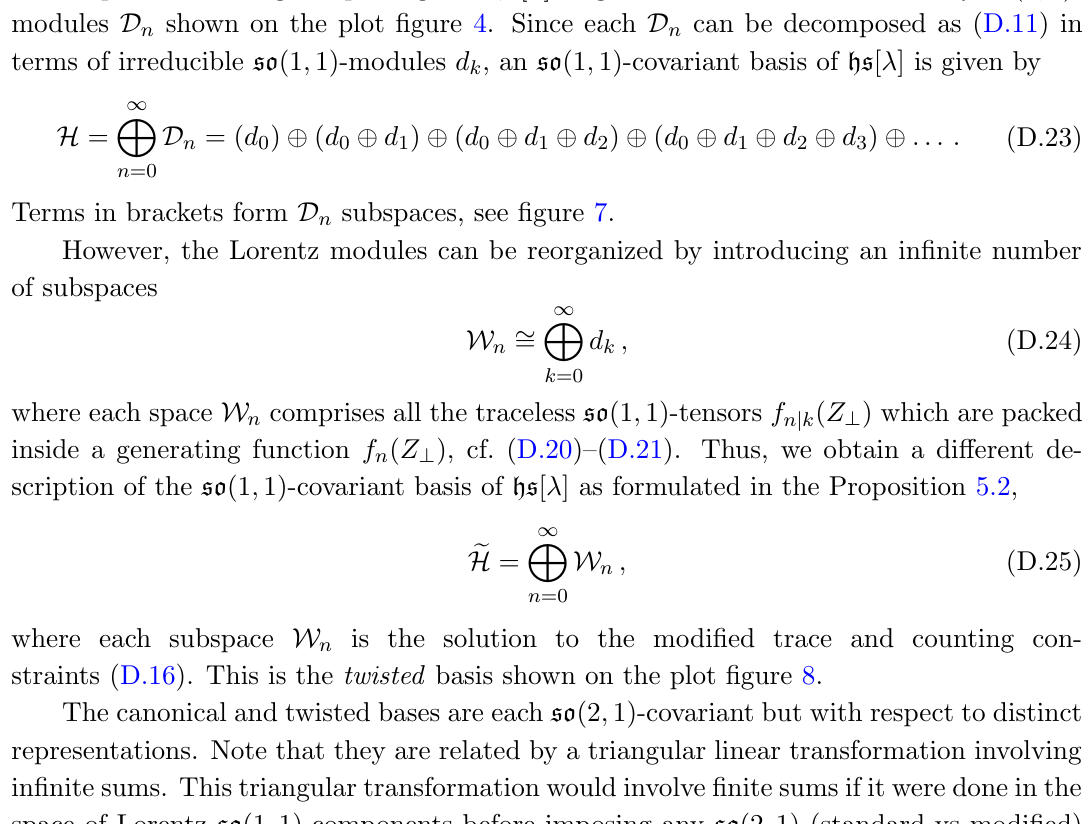
are shown in green D n has a (cid:12)xed eigenvalue on all elements inside a k